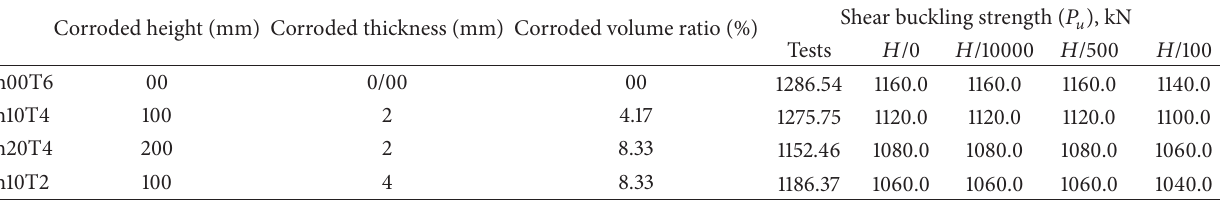
Table 2: Shear buckling strengths of test specimens and FE analysis results.